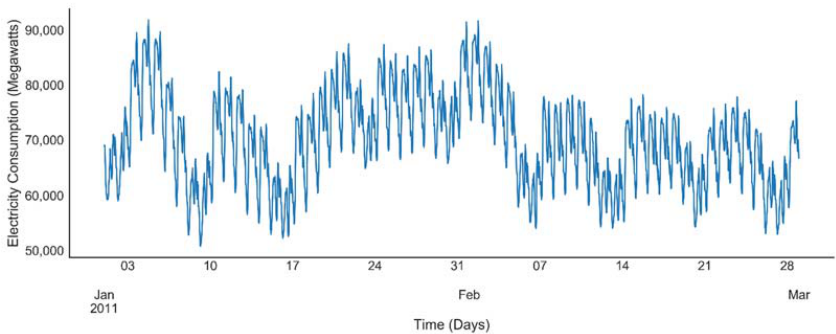
Figure 4. Electricity load versus time (January–February 2011).